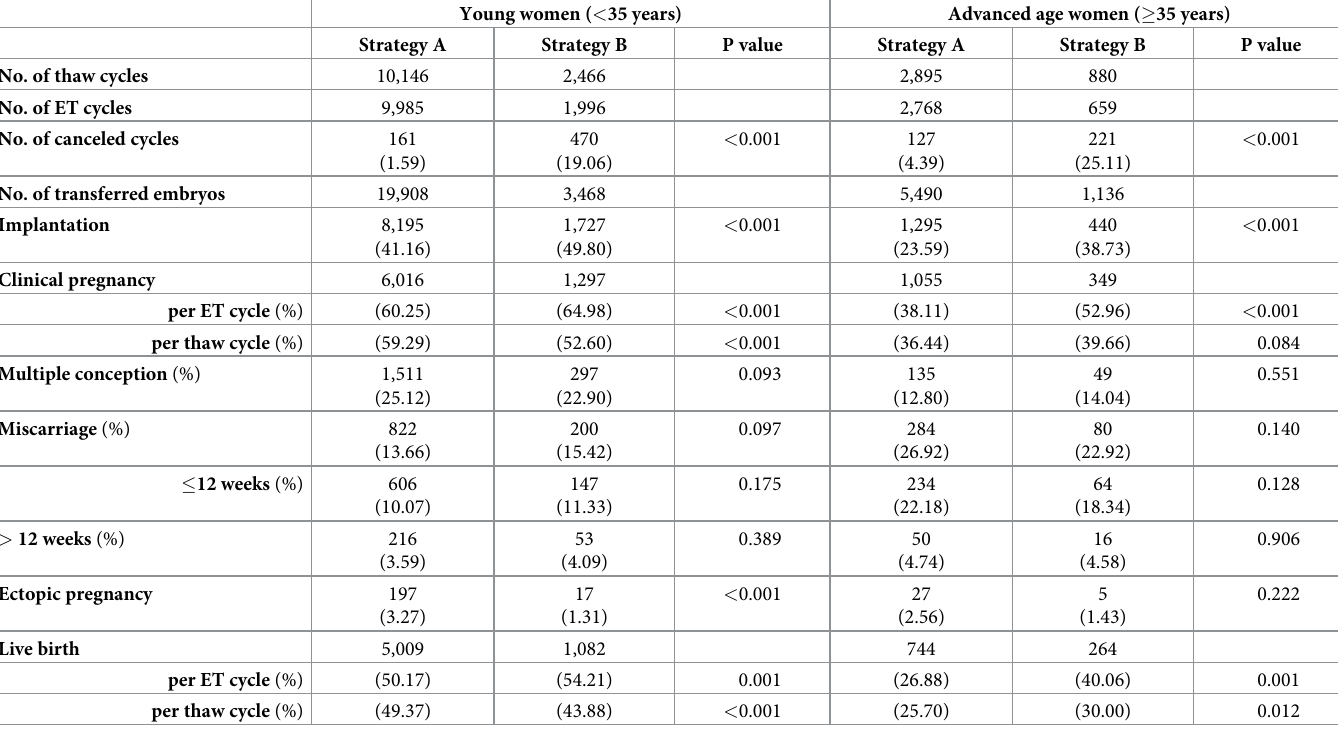
Table 2. Comparison of clinical outcomes between strategies A and B in women of young and advance age undergoing